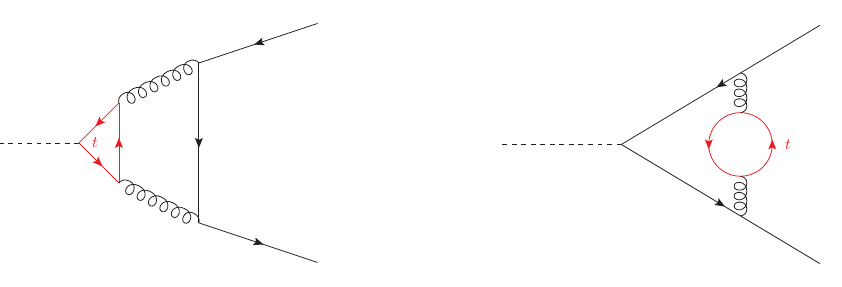
Figure 1 . Representative top-quark loop contributions for the matching of the Hq L (cid:22) q R amplitude.